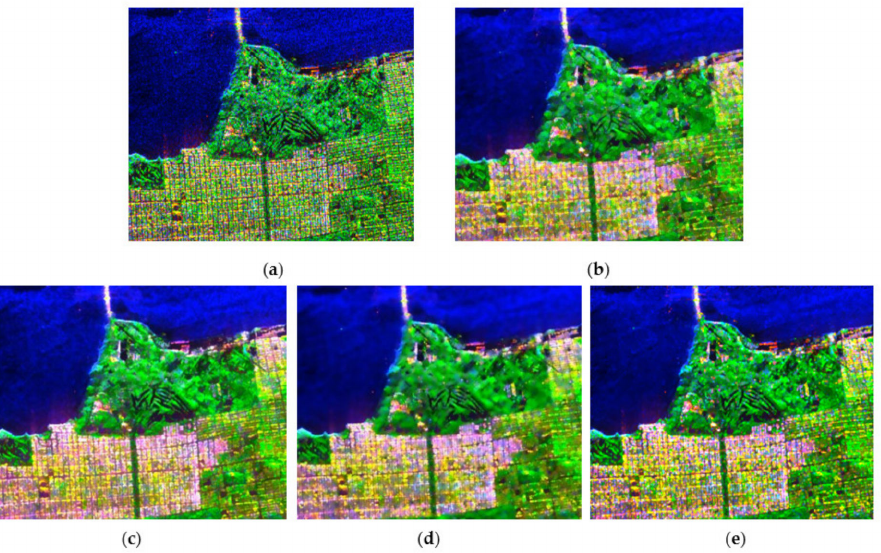
Figure 6. A comparison of the filtering results by Freeman and Durden decomposition to show their capabilities of preserving scattering properties: ( a ) Freeman RGB image of the original data; ( b ) the result of a 7 × 7 refined Lee filter, which brings in the problem of a block effect; ( c , d ) the results of NL-means and PolSAR NLTV show better performance in speckle reduction than the refined Lee filter, but the scattering mechanisms in urban areas and point targets are not well preserved; and ( e ) the result of our method effectively preserves the dominant scattering properties, reduces speckle, and retains the spatial